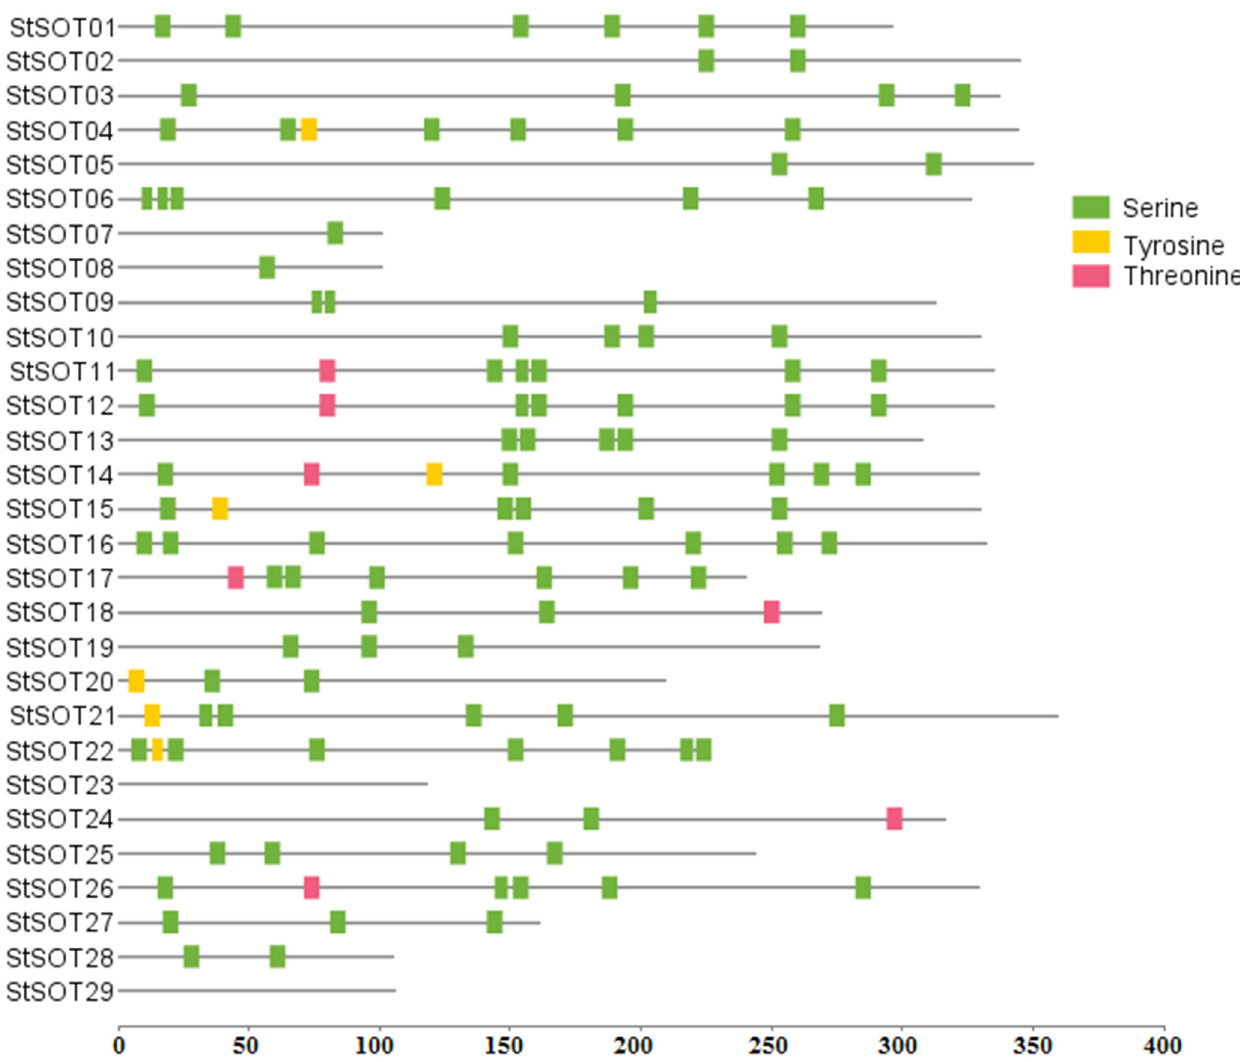
Figure 1. Phosphorylation prediction with scores ≥ 0.95 in StSOT proteins based on serine, threonine, and tyrosine, using NetPhos 3.1 server.